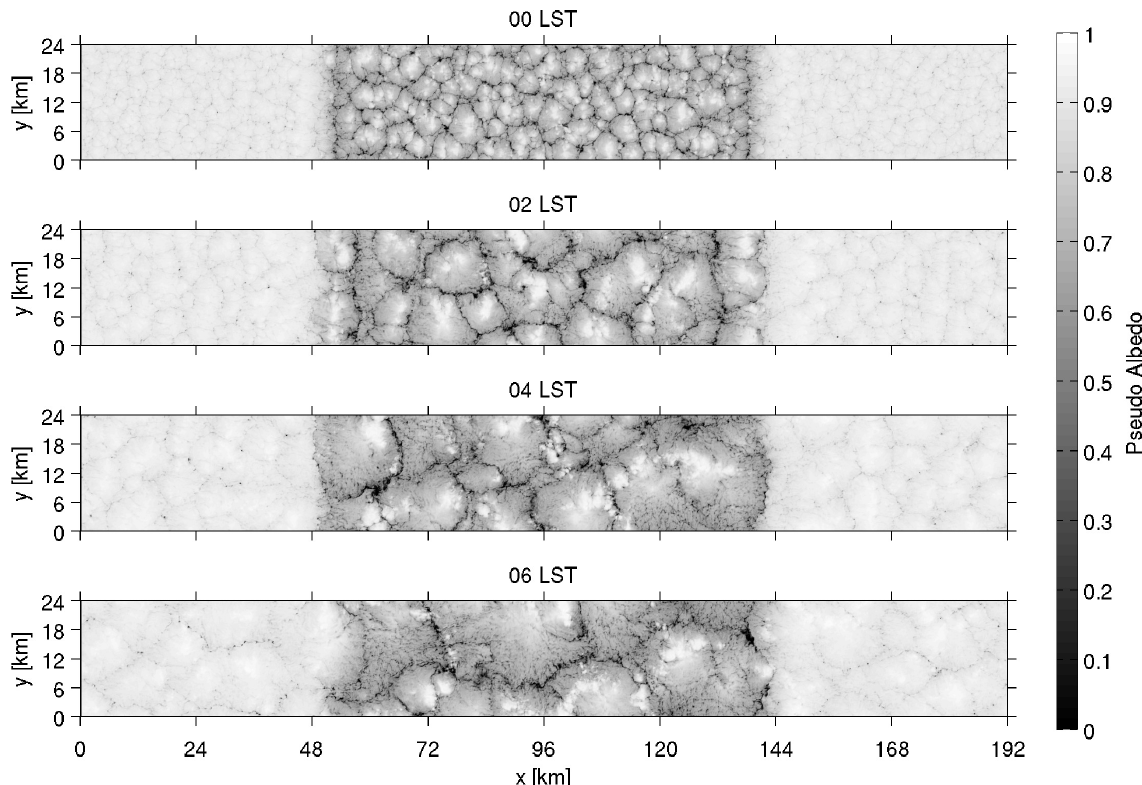
Fig. 4. Domain snapshots of pseudo-albedo for the NCFIXED run, computed from cloud optical depth following Zhang et al. (2005). Note that 00:00 LST is two hours into the simulation.